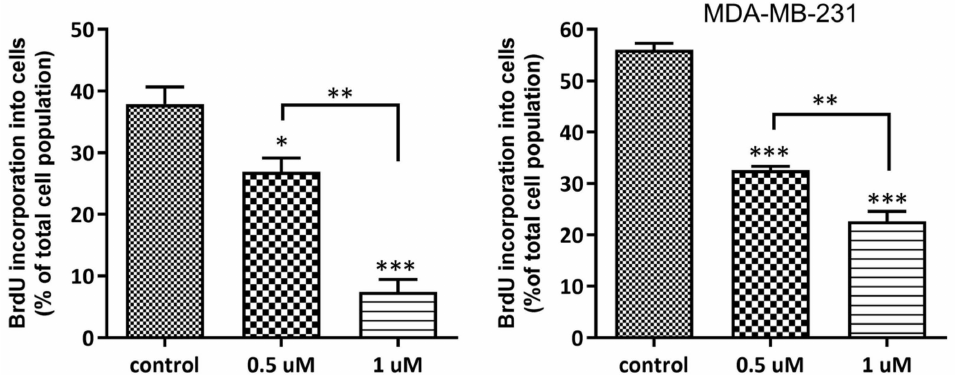
Figure 7. Effect of AJ-418 on the proliferation of MCF-7 and MDA-MB-231 cells. Cells were exposed to AJ-418 at 0.5 µ M and 1 µ M concentrations for 24 h, stained with BrdU and analyzed using flow cytometry. Error bars represent means of three replicates ± SEM. * p < 0.05, ** p < 0.01 and *** p < 0.001 were considered statistically significant compared to